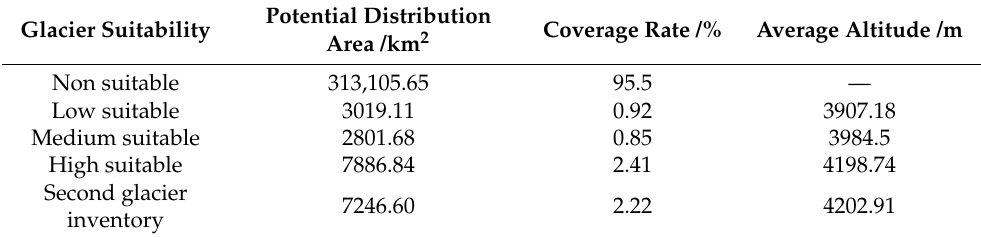
Table 3. The potential suitable distribution of glaciers in reference years (1970–2000).